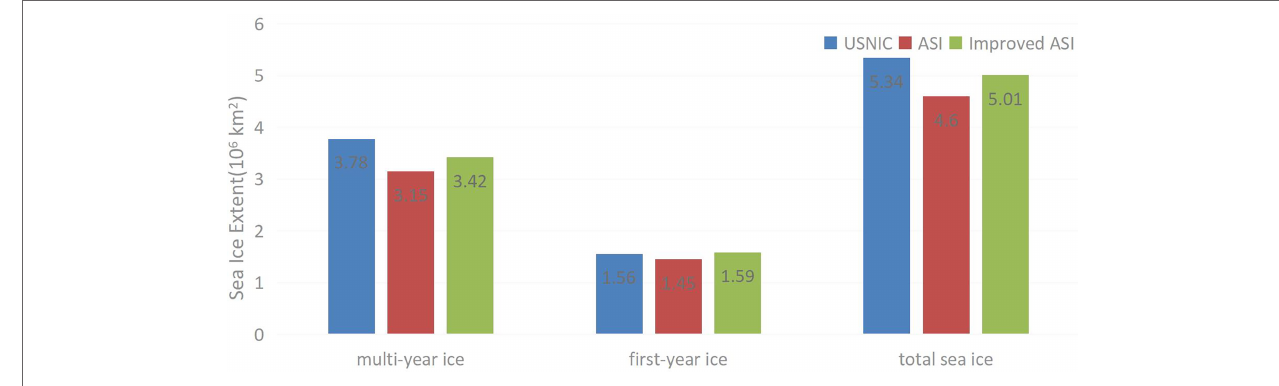
FIGURE 4 | Comparison of Antarctic sea ice